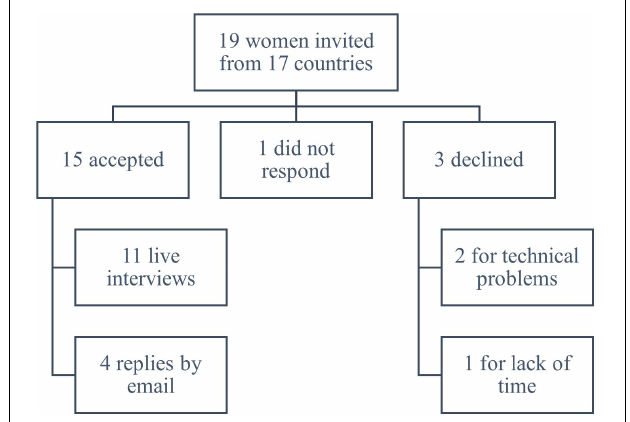
FIGURE 1 | Flowchart of interview participants from the 14 ArLAR